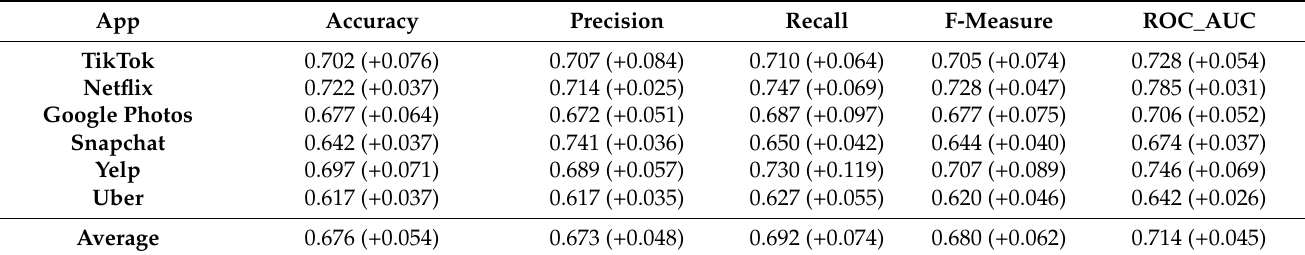
Table 10. Performance results after optimization (the number in brackets represents the